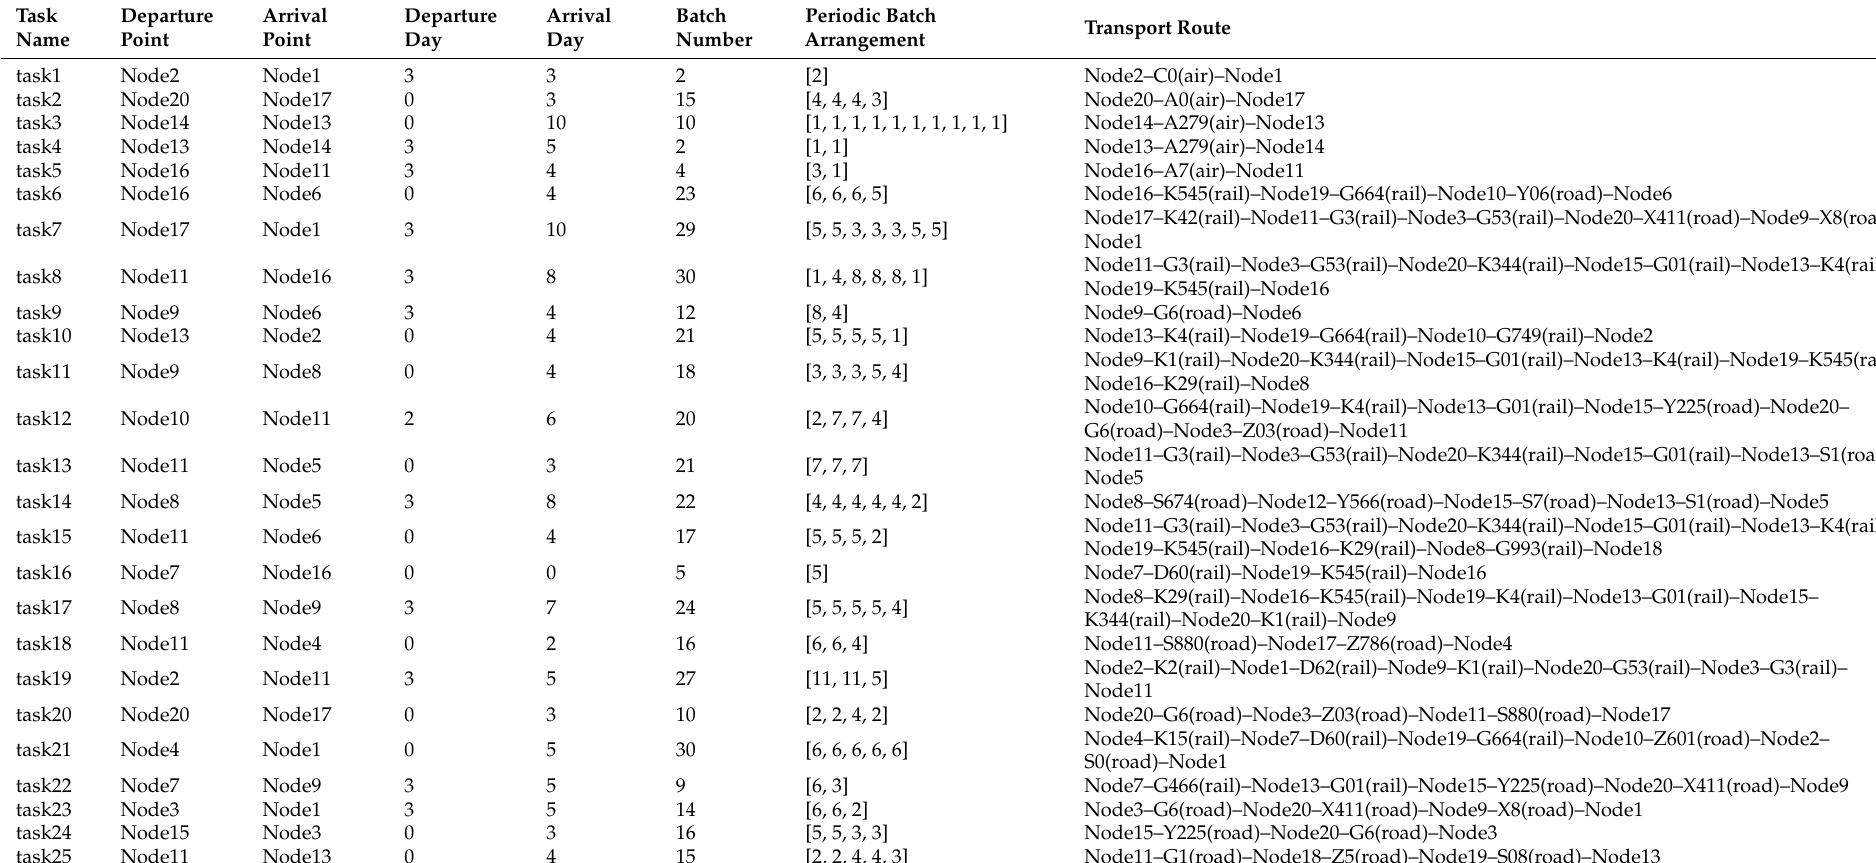
Table 4. Emergency logistic plan of